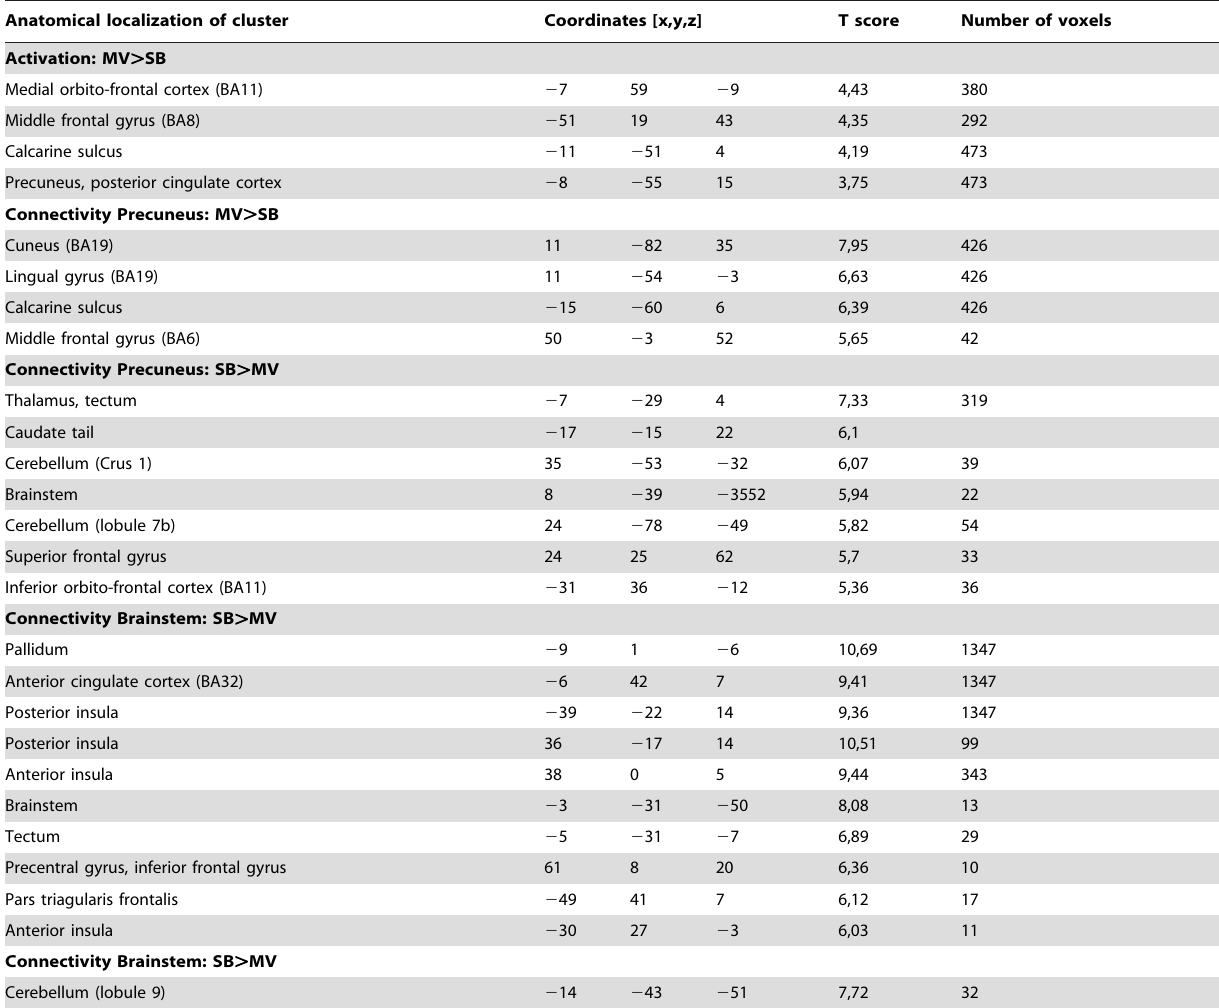
Table 1. Synthesis of fMRI